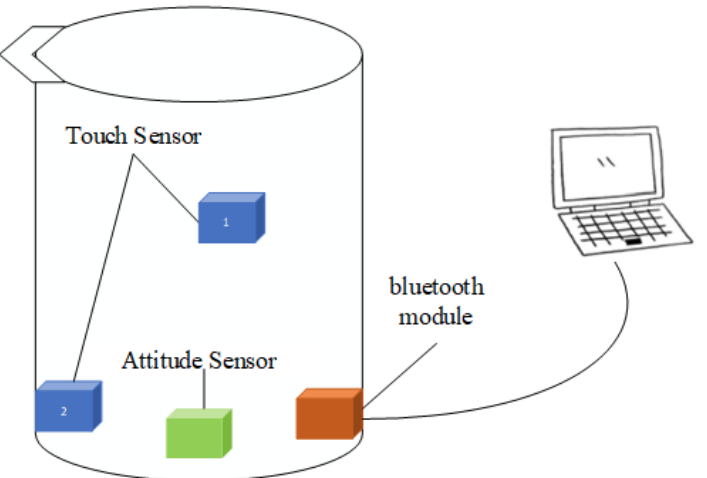
Figure 2. Intelligent